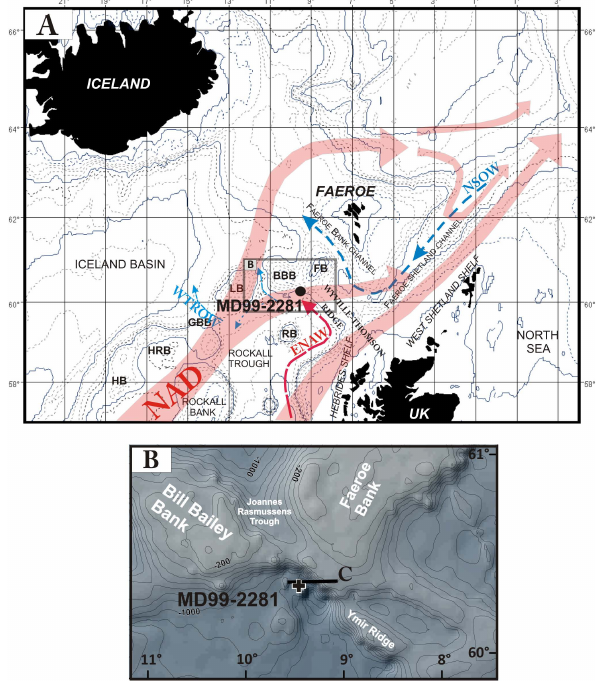
Fig. 2. Detailed physiography of the studied area. (A) Isobath: the first depth contour represents the 200m isobar on the shelf. The next depth contour is the 1000m isobar. At water depths greater than 1000m, the distance between the isobars is 1000m. Bill Bai- ley’s Bank (BBB), Faeroe Bank (FB), George Bligh Bank (GBB), Hatton Bank (HB), Hatton-Rockall Basin (HRB), Lousy Bank (LB), Rosemary Bank (RB) (Howe et al., 2006). Surface and sub- surface Currents: North Atlantic Drift (NAD), East North Atlantic Water (ENAW). Bottom currents: Norwegian Sea Overflow Wa- ter (NSOW), North East Atlantic Deep Water, Wyville-Thompson Ridge Overflow Water (WTROW) (Kuijpers et al., 1998, 2002; Hol- liday et al., 2000; New and Smythe-Wright, 2001; Howe et al., 2006). (B) Bathymetric map (contour interval 100m) zooming on the core site with location of the C seismic section documented by Boldreel et al. (1998), who identified pelagic deposits unaffected by currents in the coring